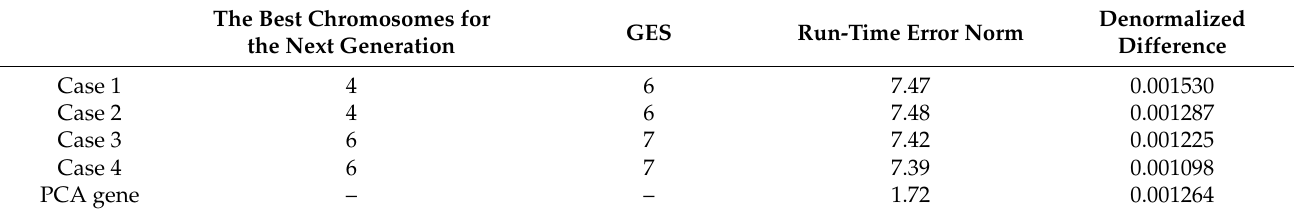
Table 4. The ANN training result under GA “back-to-original”